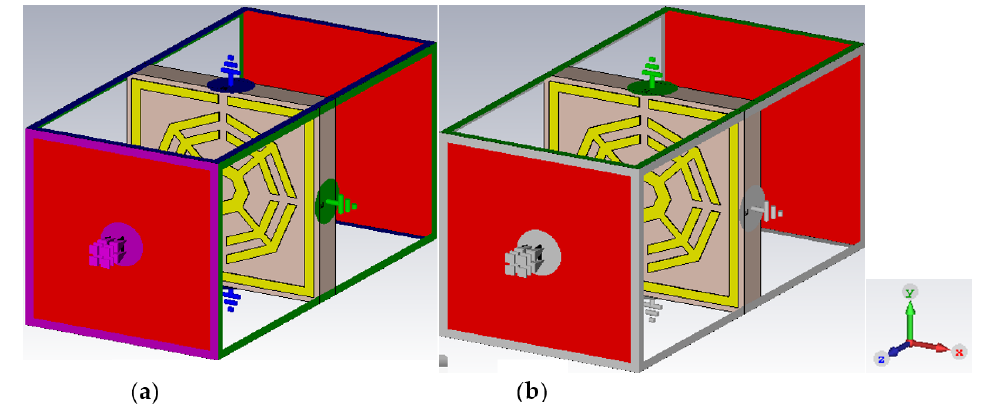
Figure 6. Application of changing electric and magnetic field directions: ( a ) ExHy; ( b ) EyHx.